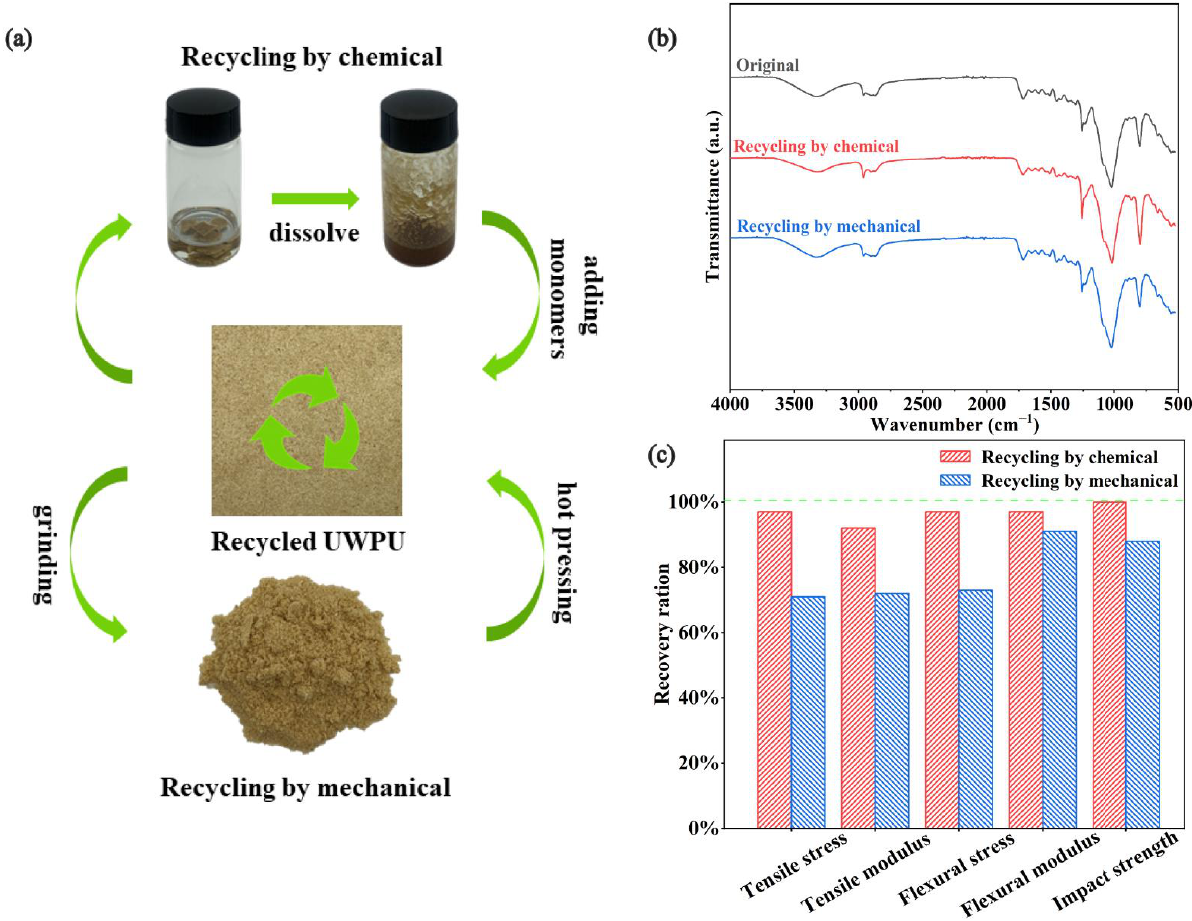
Figure 9. Recycling properties of the UWPU: ( a ) the digital photographs of the chemical recycling process and the mechanical recycling process, ( b ) the FT-IR spectra of the recycled UWPU, and ( c ) the recovery ratio of tensile strength, tensile modulus, flexural strength, bending modulus, and impact strength of the recycled UWPU.